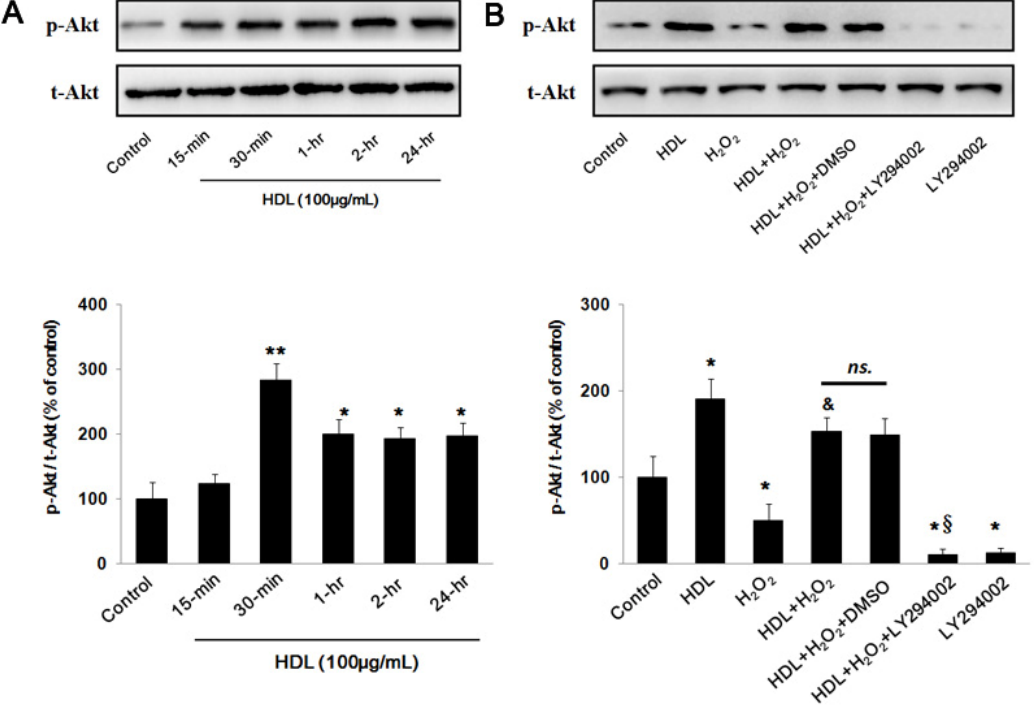
Figure 3. Role of PI3K/Akt pathway in the HDL induced anti-apoptotic protection. ( A ) Western blot analysis show that HDL significantly increased Akt phosphorylation in MSCs. ( B to D ) MSCs were pre-incubated with LY294002 (25 μ M) or DMSO for 1 h and then exposed to HDL (100 μ g/mL) followed by exposure to H 24 h. Western blotting results show that Akt phosphorylation induced by HDL was decreased by pre-incubation with LY294002. The protective effect of HDL evidenced by cell viability and caspase-3 activity was significantly abolished by LY294002. Results were confirmed in three, independent experiments. * p < 0.05 vs. Control, ** p < 0.01 vs. ns. , not significant; DMSO, Dimethyl